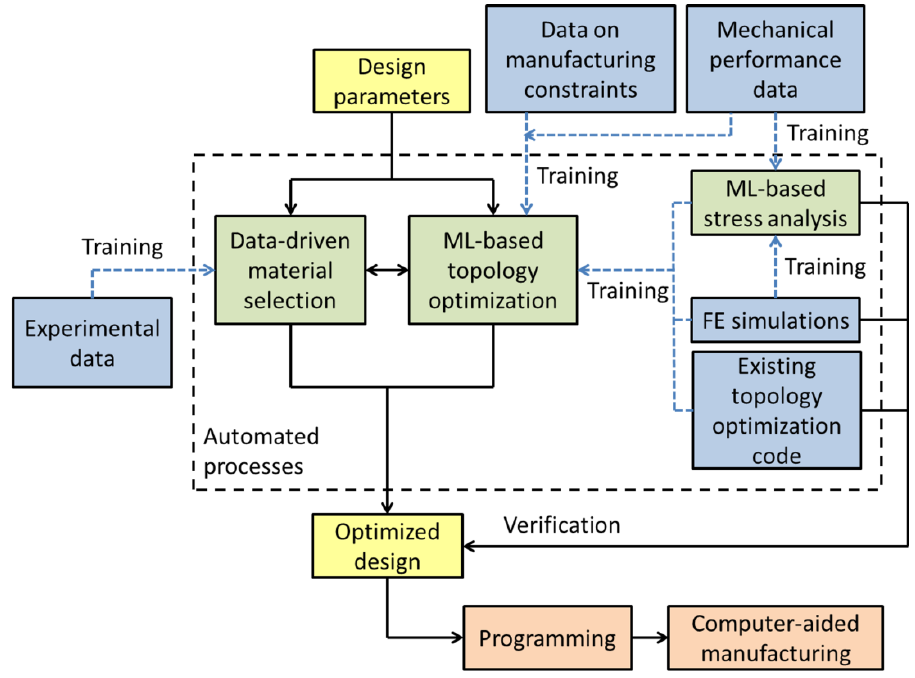
Figure 9. A proposed automated design framework for fiber-reinforced polymer composites